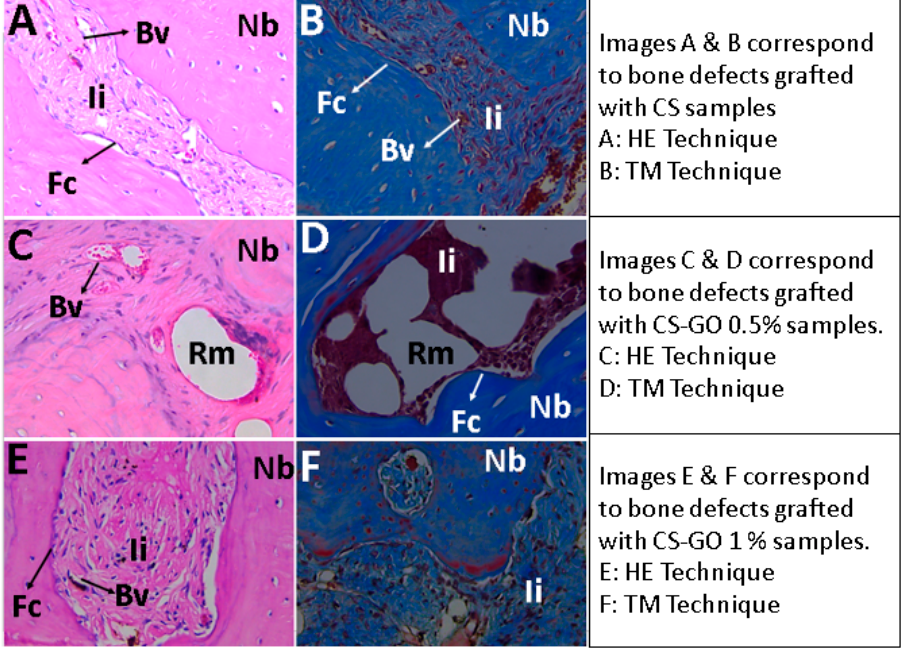
Figure 4. Experimental samples with images at 40×. Nb: Newly born bone, Ii: Inflammatory infiltrate, Rm: Remnant material, Fc: Fibrous capsule, Bv: Blood vessel.